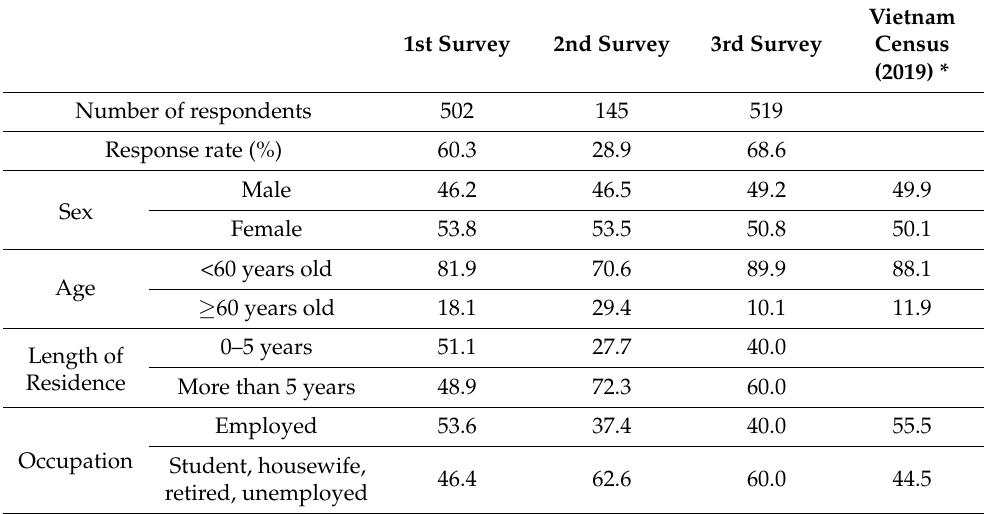
Table 3. Demographic characteristics of the survey respondents, including age, gender, length of residence, and occupation.